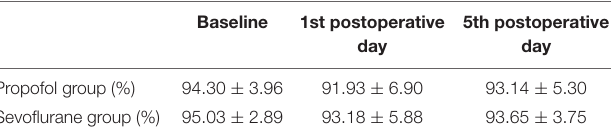
TABLE 2 | Accuracy of patients (x ±